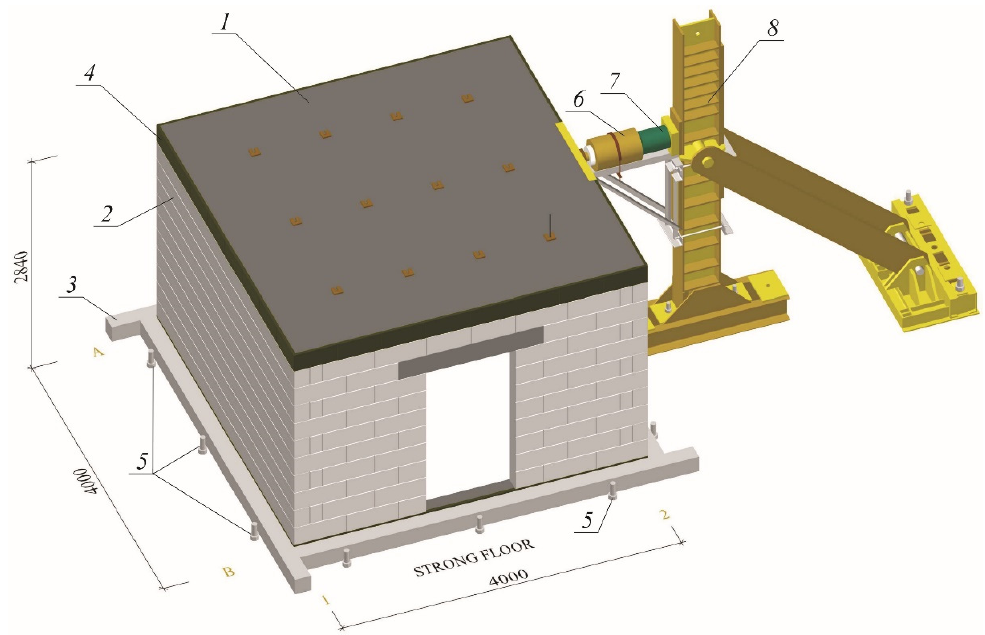
Figure 4. Research model in the test stand; 1 —slab; 2 —masonry wall made of autoclaved aerated concrete units; 3 —ring bottom beam; 4 —ring top beam; 5 —fixing the building model in the slab of great forces; 6 —hydraulic cylinder; 7 —force gauge; 8 —steel column.